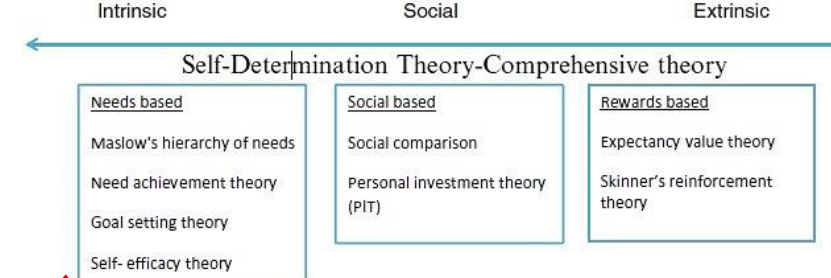
Figure 2. Model of motivation in games [20, 21]